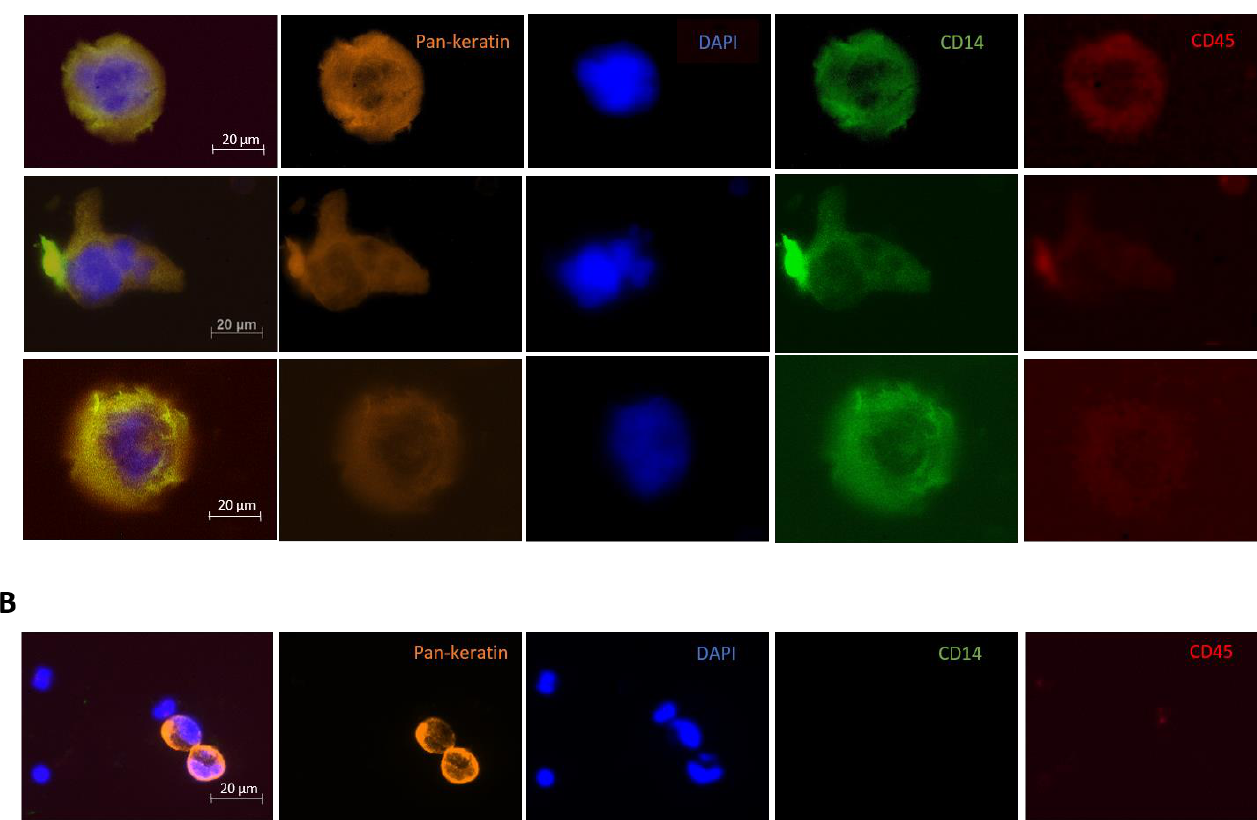
Figure 1. CAMLs and CTCs detected via immunofluorescence staining. ( A ) Different shapes of CAMLs detected in PDAC patients. ( B ) 2 CTCs in a PDAC patient.